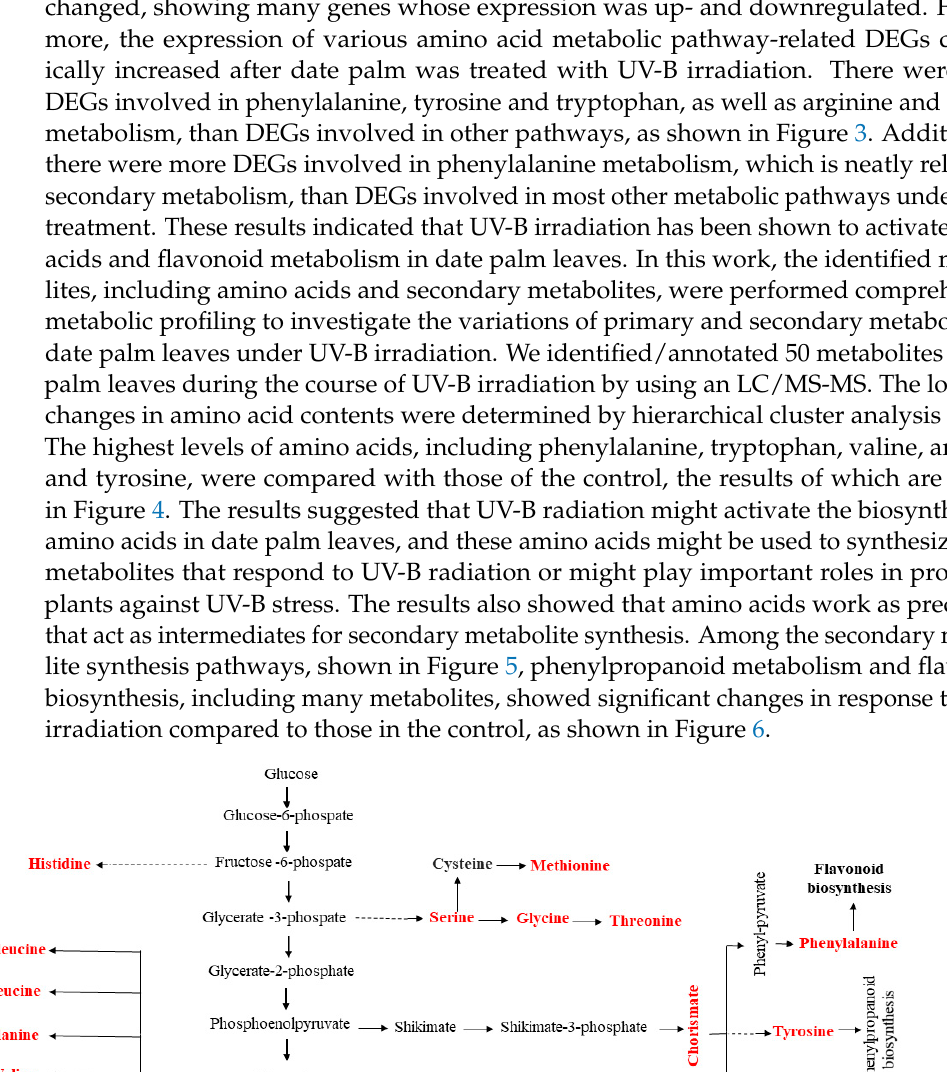
Figure 4. Variations in amino acids levels in date palm leaves under UV ‐ B irradiation compared to the controls. The log2 (fold change) value of three samples treated compared to the control was normalized to complete hierarchical clustering analysis. Red indicates higher amino acid contents in treated samples than in the control, whereas green indicates lower amino contents in treated samples compared to the controls.